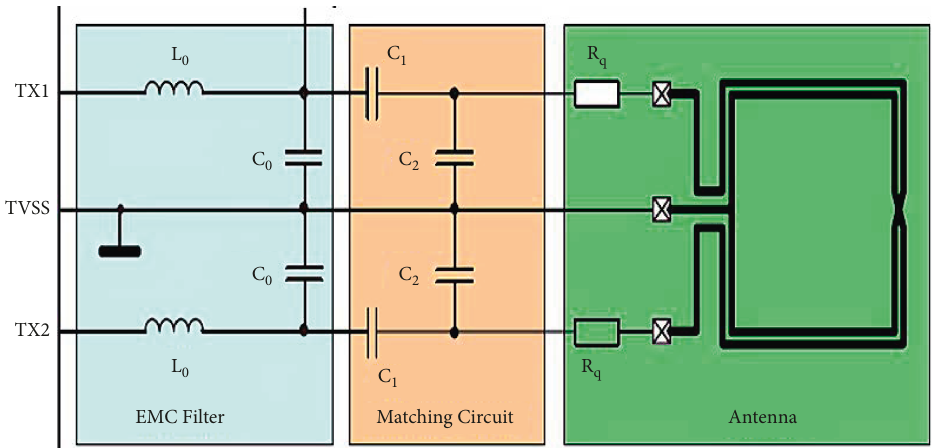
Figure 5: Antenna matching schematic diagram. Rq , damping